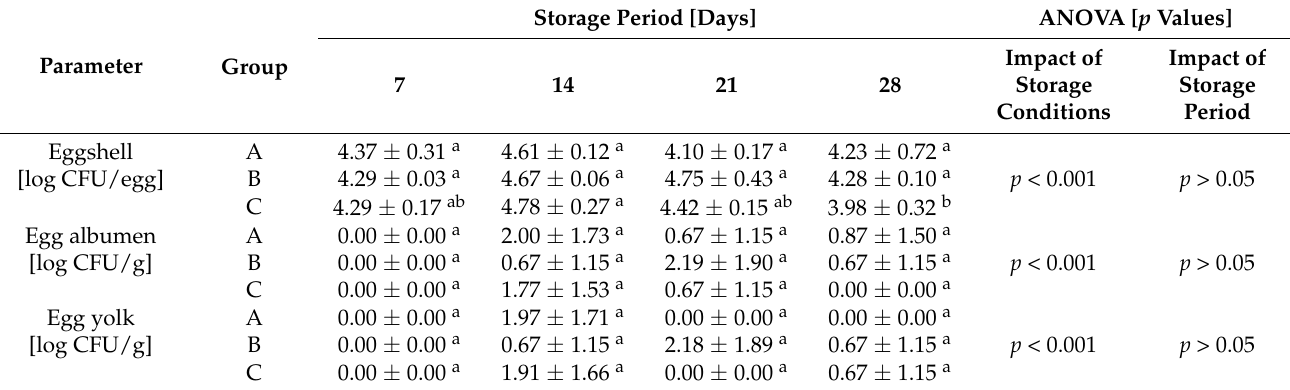
Table 2. Numbers of molds in experimental groups of table eggs during the storage period (mean ±